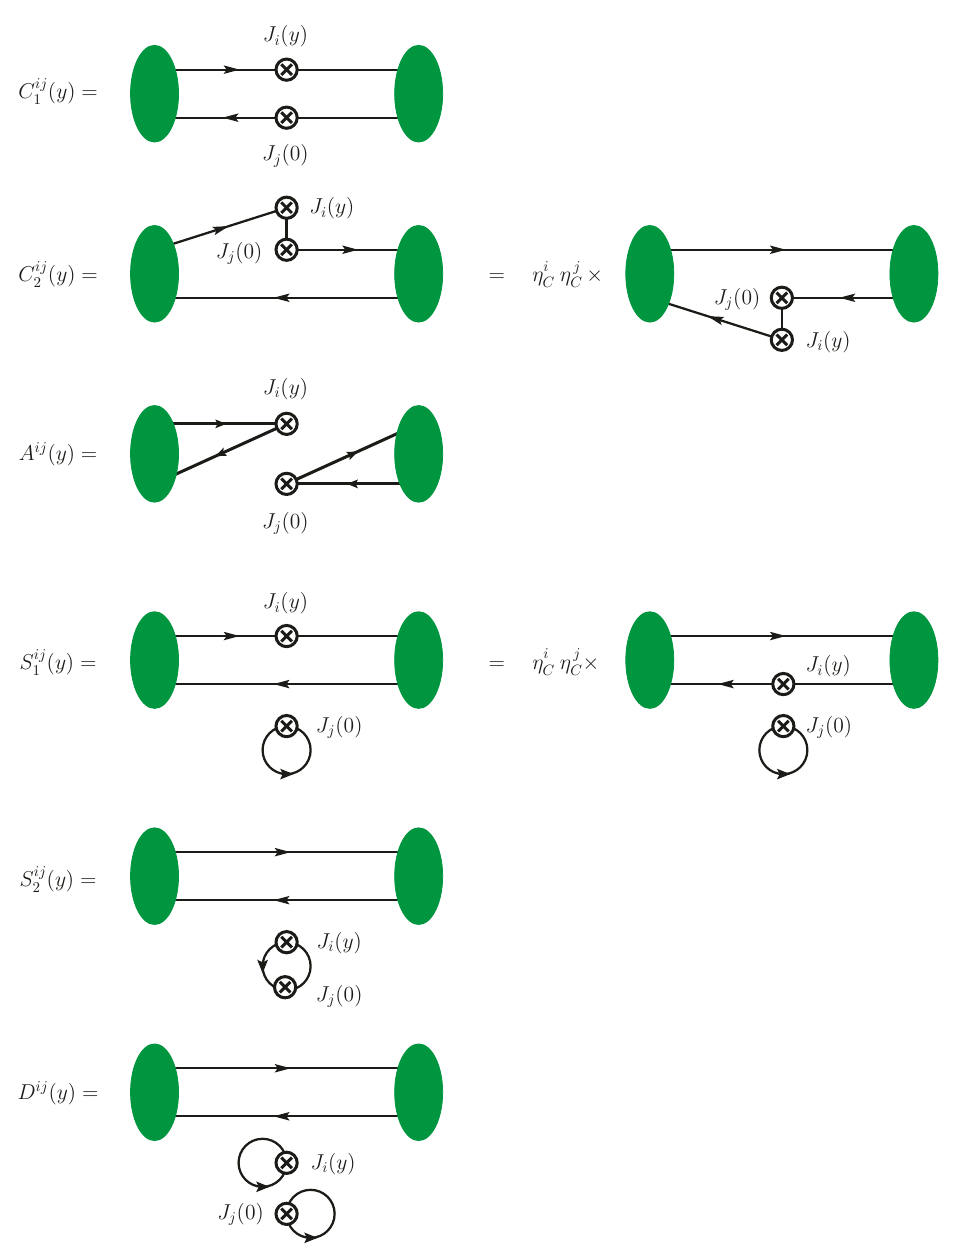
Figure 4 . Lattice graphs for the correlation functions used to extract the matrix elements (2.8) in a pion. The dependence on the pion momentum ~p is not indicated for brevity. η i charge conjugation parity of the current J i and is defined in